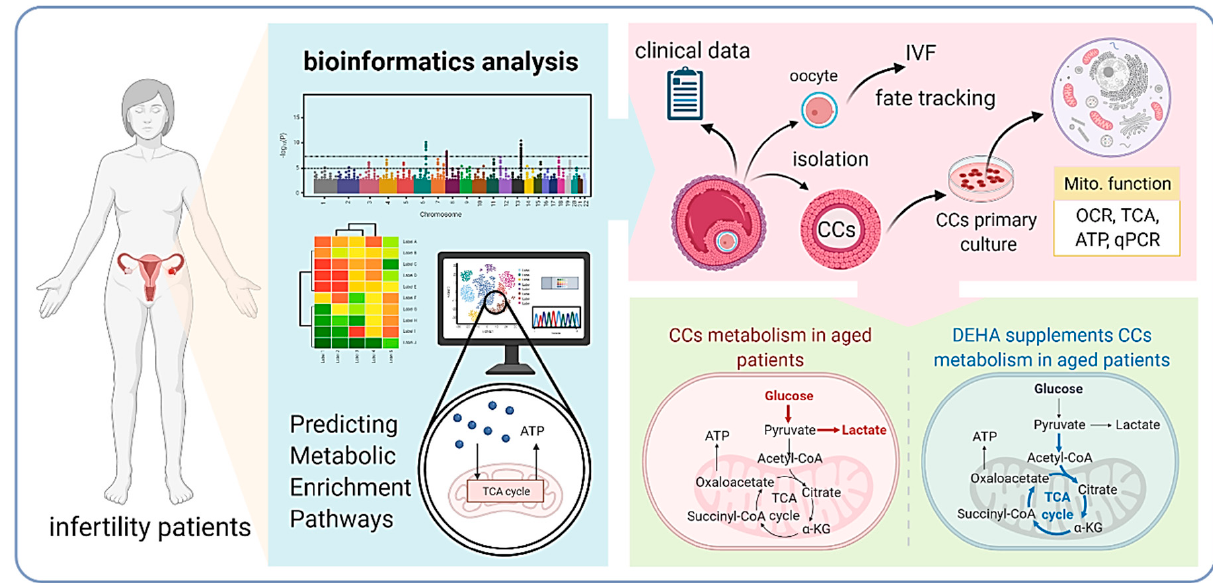
Figure 5. Proposed model of DHEA regulation of metabolic pathways in infertile patients. Supplementary Materials: The following are available online at www.mdpi.com/xxx/s1, Table S1: